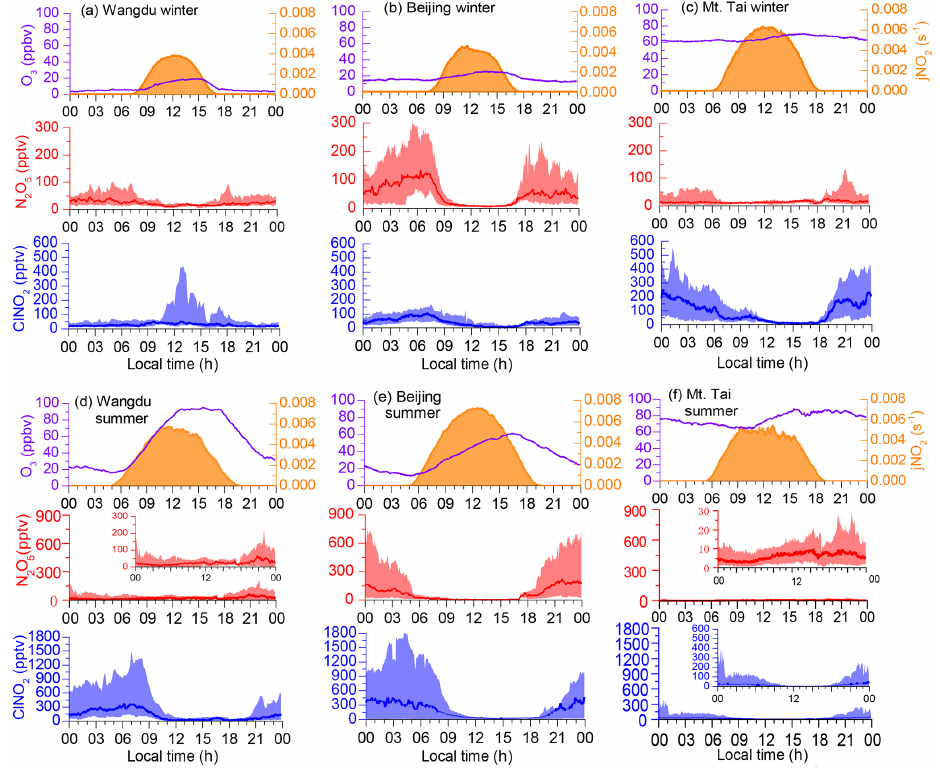
Figure 2. Diurnal average levels of N 2 O 5 , ClNO 2 , O 3 , and j NO 2 observed at the Wangdu, Beijing, and Mt. Tai sites throughout the campaign in winter (this study) and previous summer field studies (Table 1). The shaded areas indicate the 10th and 90th